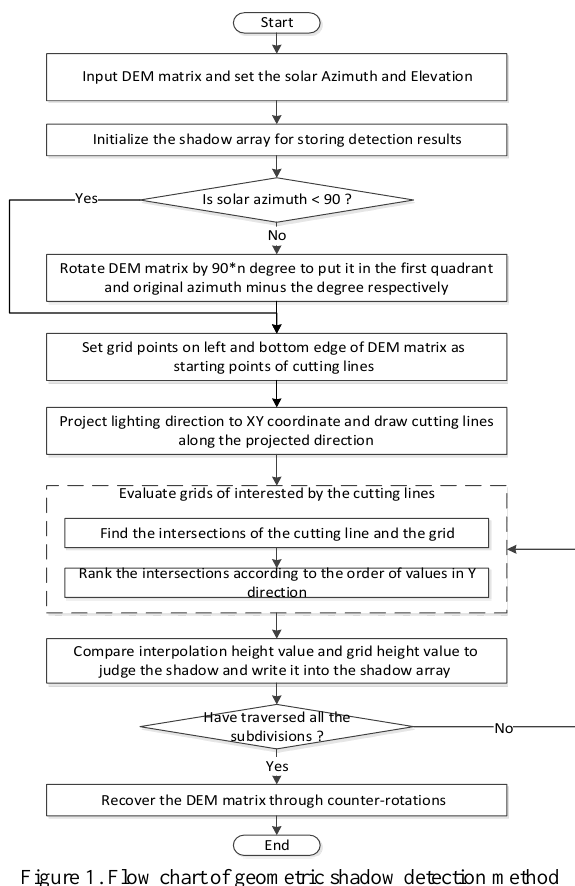
Figure 1. Flow chart of geometric shadow detection method